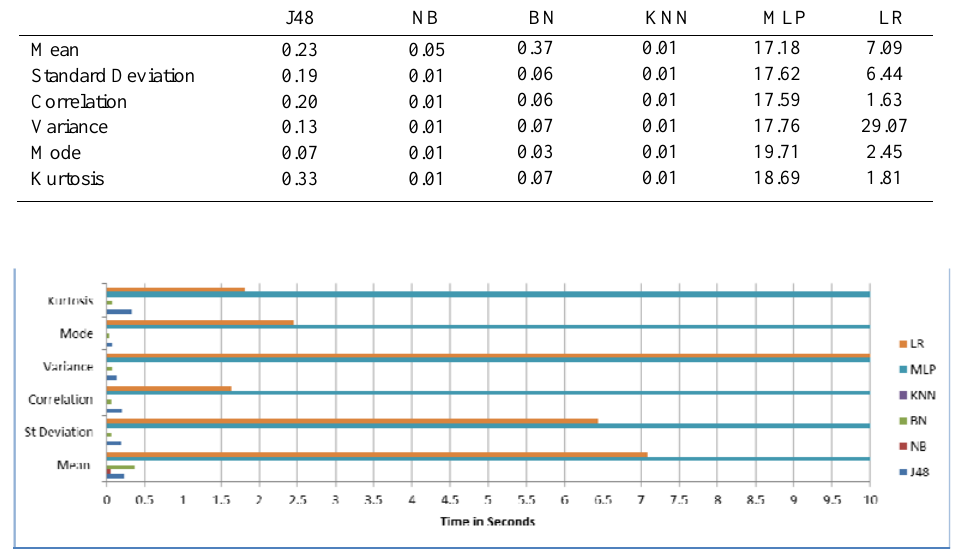
Fig. 5. Time taken to build classification model – algorithm vs. algorithm